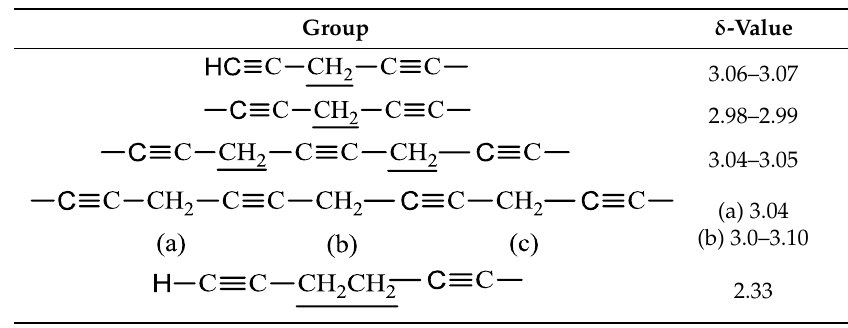
Table 8. 1 H-NMR chemical shifts of some characteristic groups in polyynoic fatty acids and esters (in